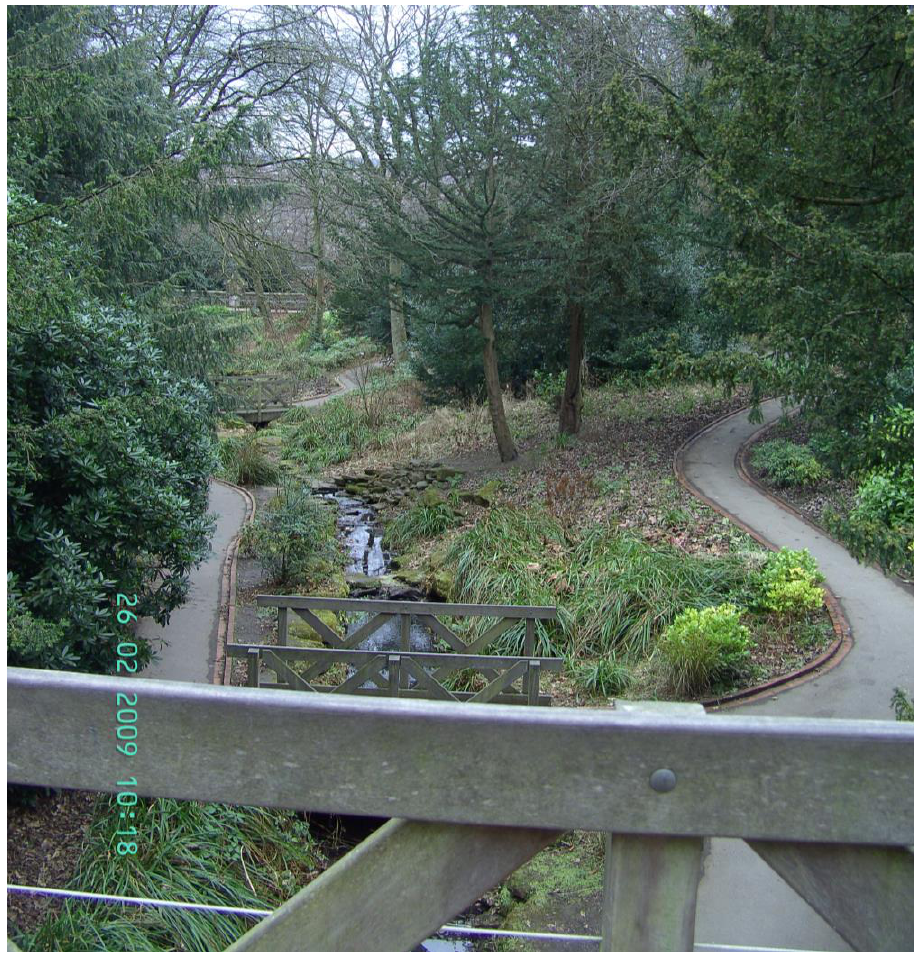
Figure 3. The Dene.